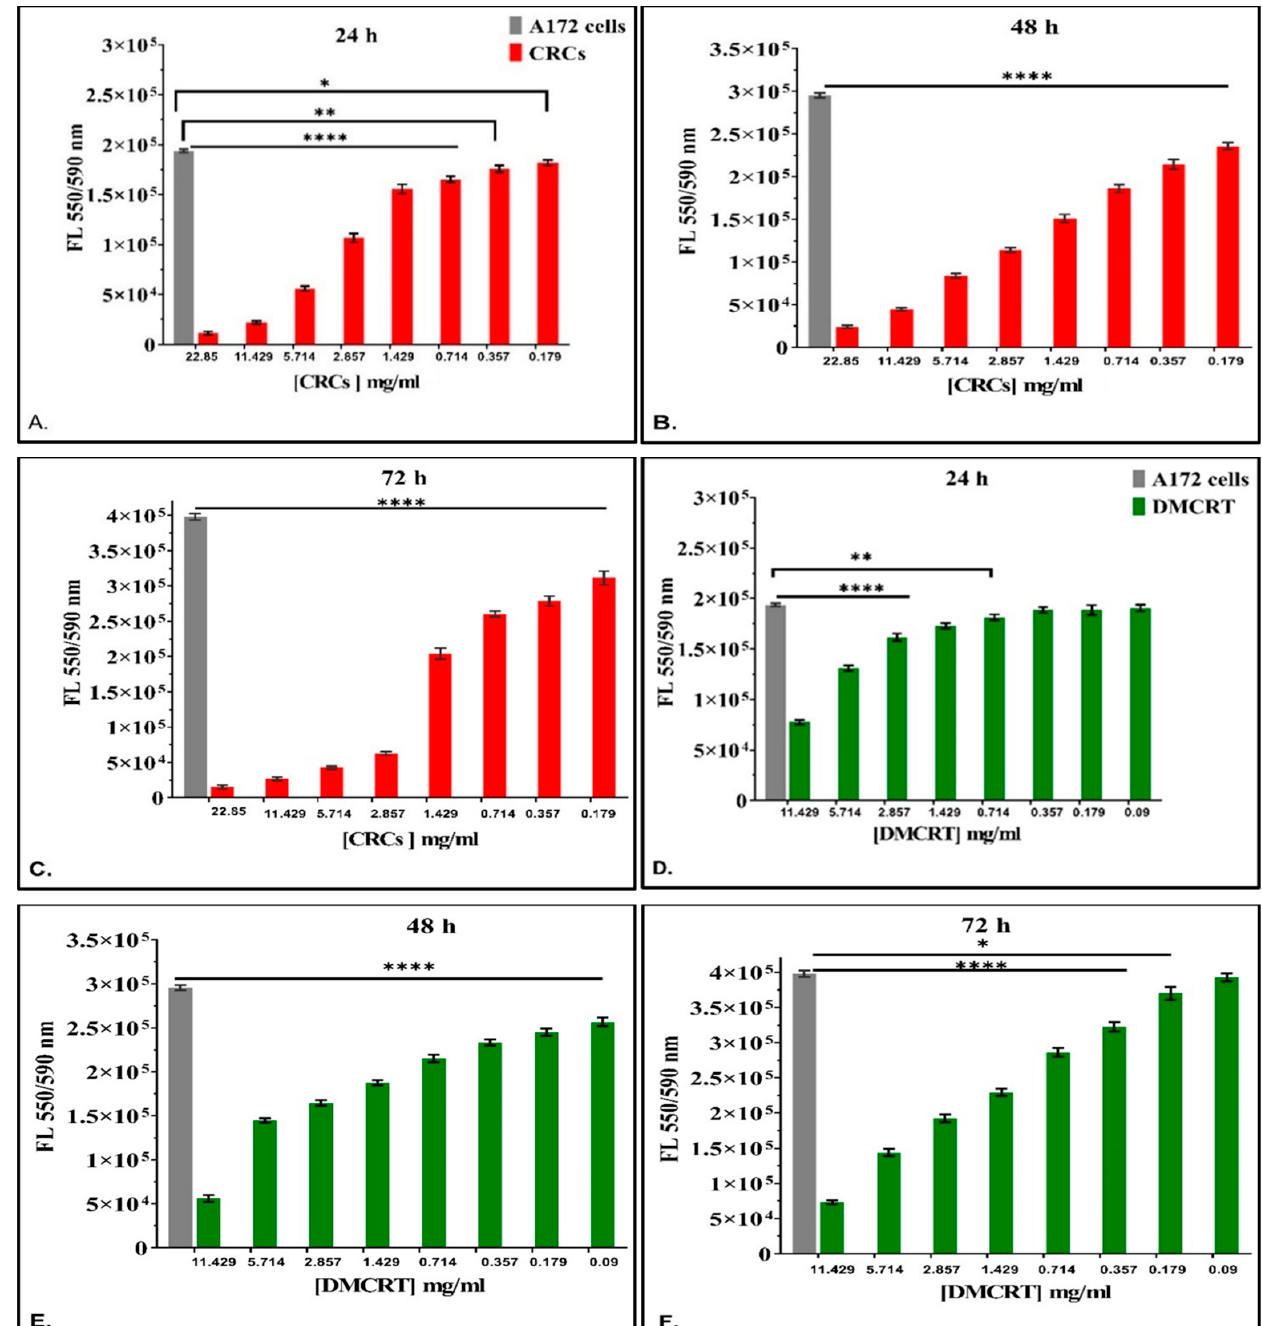
Figure 1. Dose-dependent effect of CRCs and DMCRT on A172 cells. CRCs exhibited a significant dose-dependent effect at all time points and for concentrations ≥ 0.179 mg/mL tested ( p < 0.05 for cells exposed to any concentration of CRCs vs untreated A172) ( A – C ). Similarly, DMCRT was also effective from concentrations ≥ 0.714 mg/mL and ≥ 0.179 mg/mL, at 24 and 72 h respectively and for all concentrations, at 48 h, manifesting significant increasing cell fatal effects with increasing concentrations ( D – F ). Legend : CRCs : Crocins, DMCRT : dimethylocrocetin, FL : Fluorescence Intensity. Asterisks (*) depict at least p < 0.05 significance level between control experiments and CRCs (* p < 0.05; ** p < 0.01; **** p < 0.0001). Each value represents the mean ± S.D. of triplicate experiments.